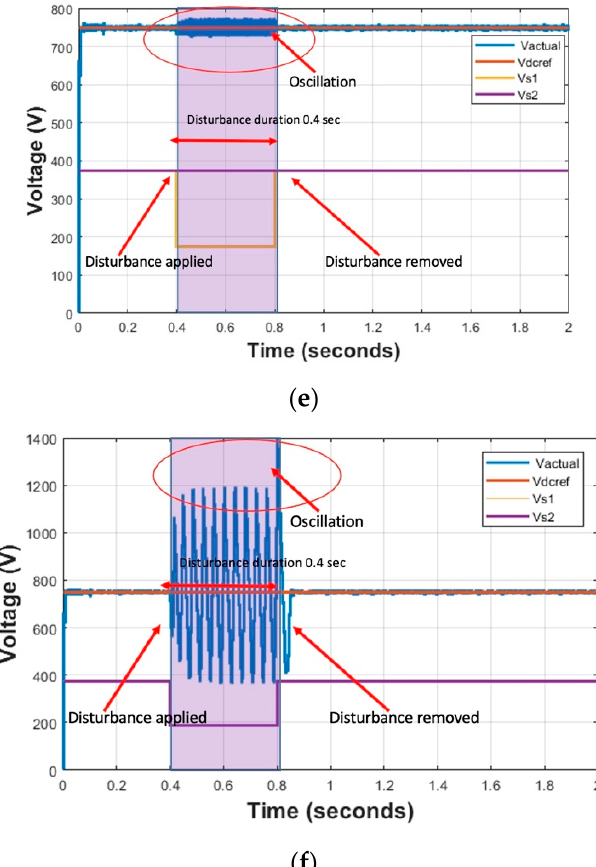
Figure 10. Impact of the controller and DC link dynamics on DC bus. ( a ) DC bus voltage influenced by integral controller dynamics; ( b ) FFT analysis on DC bus; ( c ) parameter variations of the controller (buck converters); ( d ) DC bus voltage influenced by the proportional controller dynamics; ( e ) impact of simultaneous disturbances (50% voltage disturbances in source 1 and 50% load disturbances); ( f ) impact of simultaneous disturbances (50% voltage disturbances in source 1 and source 2, and 50% load disturbances).